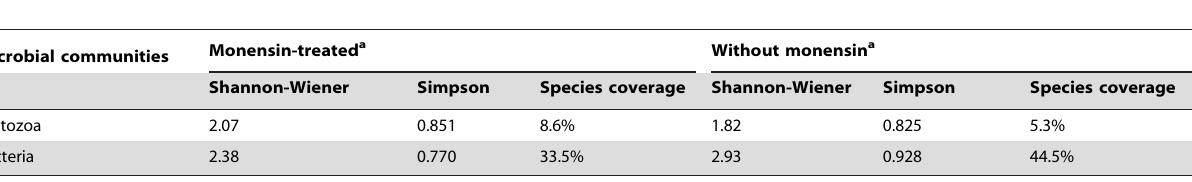
Table 1. Species diversity and richness of bacterial and protozoan communities in dairy wastewater treated with or without monensin.